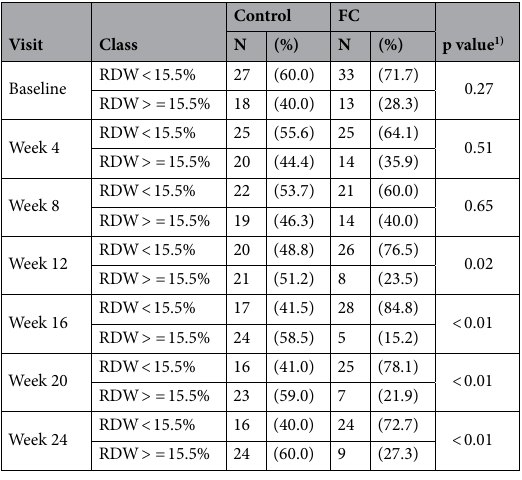
Table 4. Achievement ratio of RDW < 15.5% 1) Fisher’s exact test.